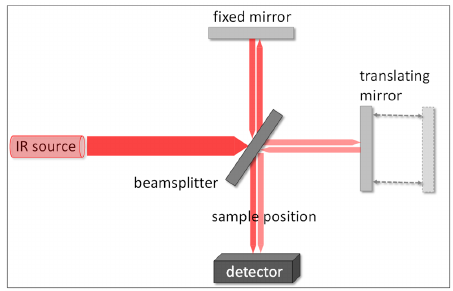
Figure 4. Schematic representation of a Michelson interferometer. 195